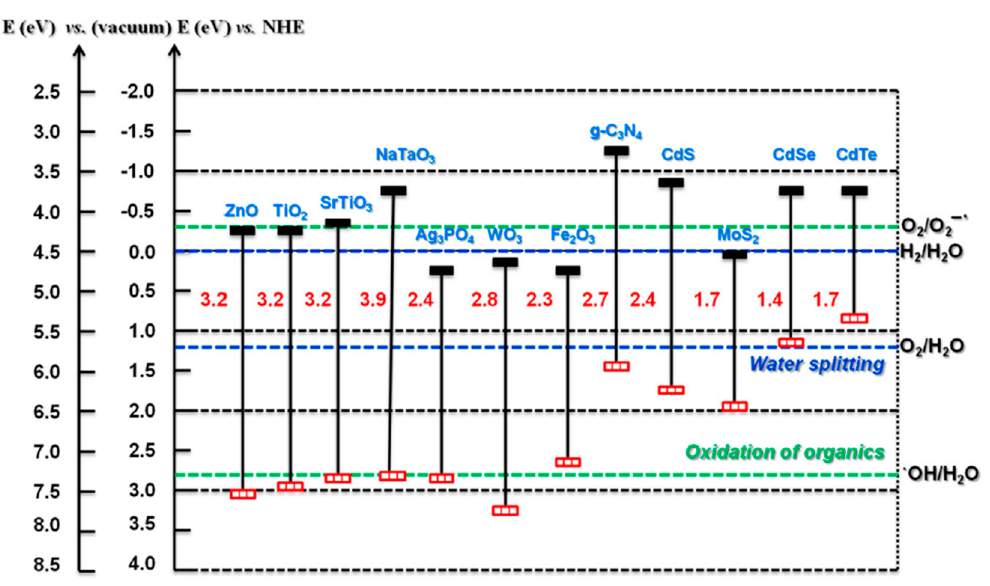
Figure 2. A schematic illustration of the band-gap energy of several typical semiconductor photocatalysts. Reproduced with permission from [41].